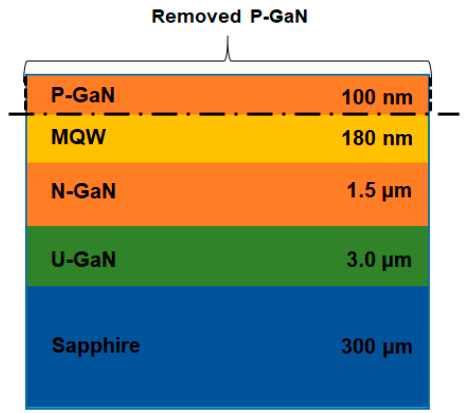
Figure 1. Schematic of GaN blue LED epitaxial wafer layers.